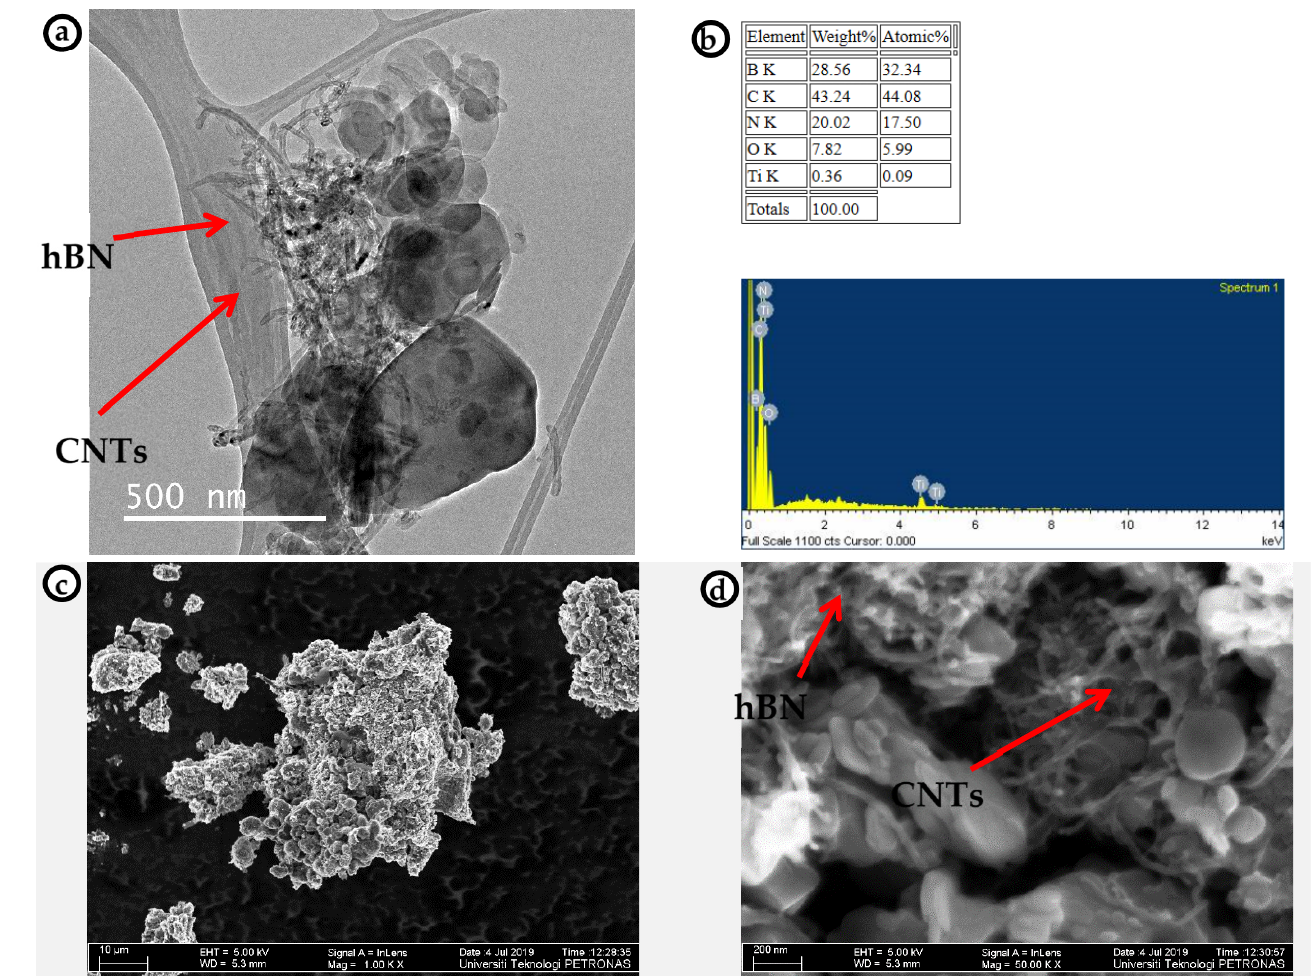
Figure 4. Photographs of CF-CNTs with hBN nanocomposite: HRTEM hybrid ( a ), EDX ( b ), and FESEM ( c , d ).